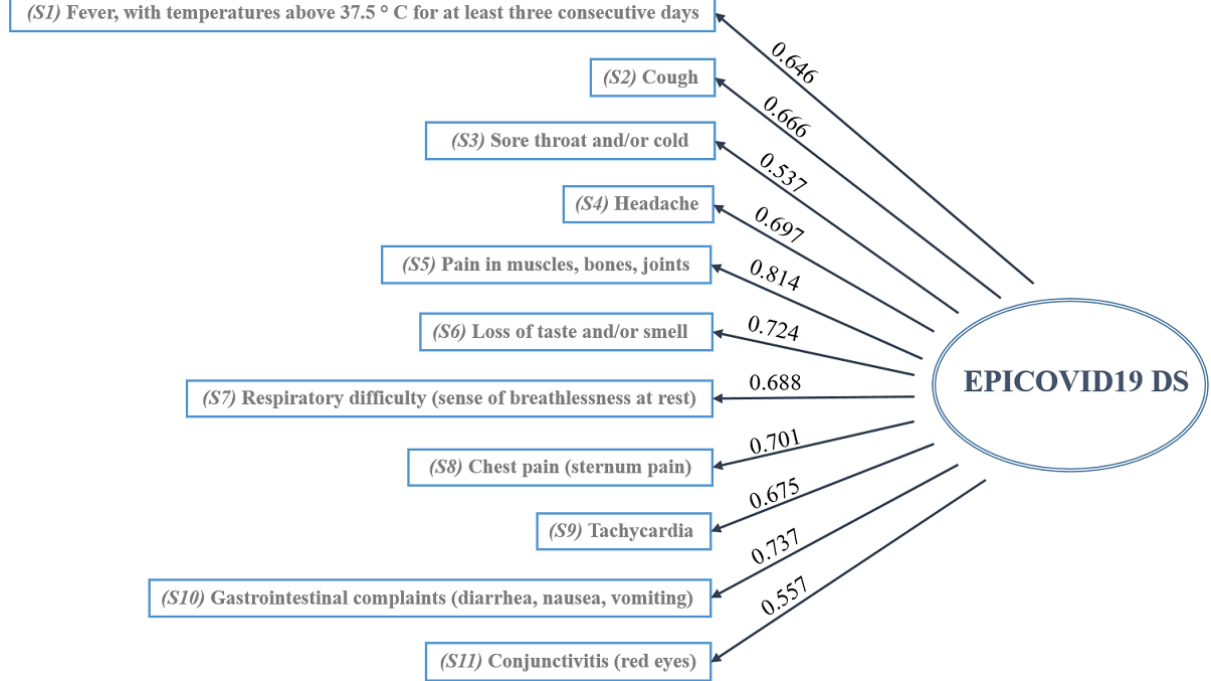
Figure 2. Standardized factor loading values of the 1-factor model, EPICVOID19 DS. The goodness-of-fit indices are as follows: a standardized root mean square residual of 0.072, root mean square error of approximation of 0.052, comparative fit index of 0.977, and Tucker-Lewis index of 0.971. EPICOVID19 DS: EPICOVID19 diagnostic